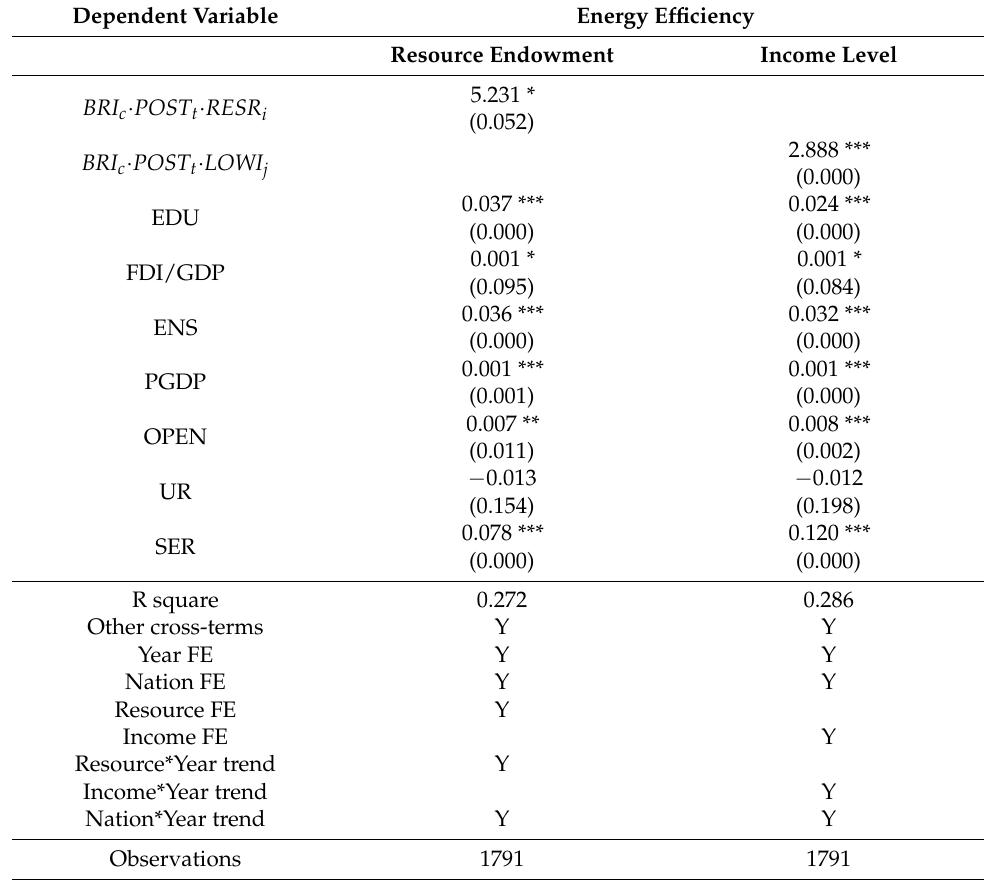
Table 4. Regression results by the DDD